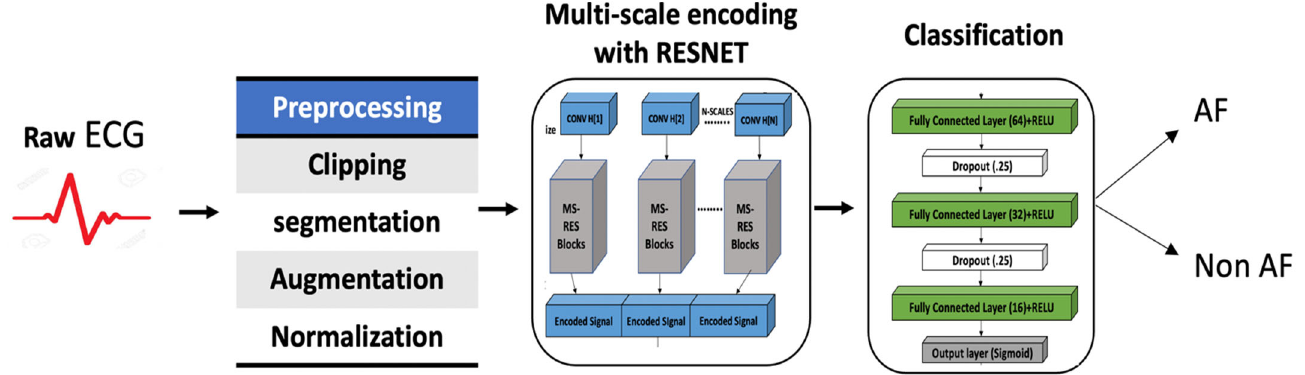
Figure 4. The workflow of the proposed atrial fibrillation (AF) detection method.